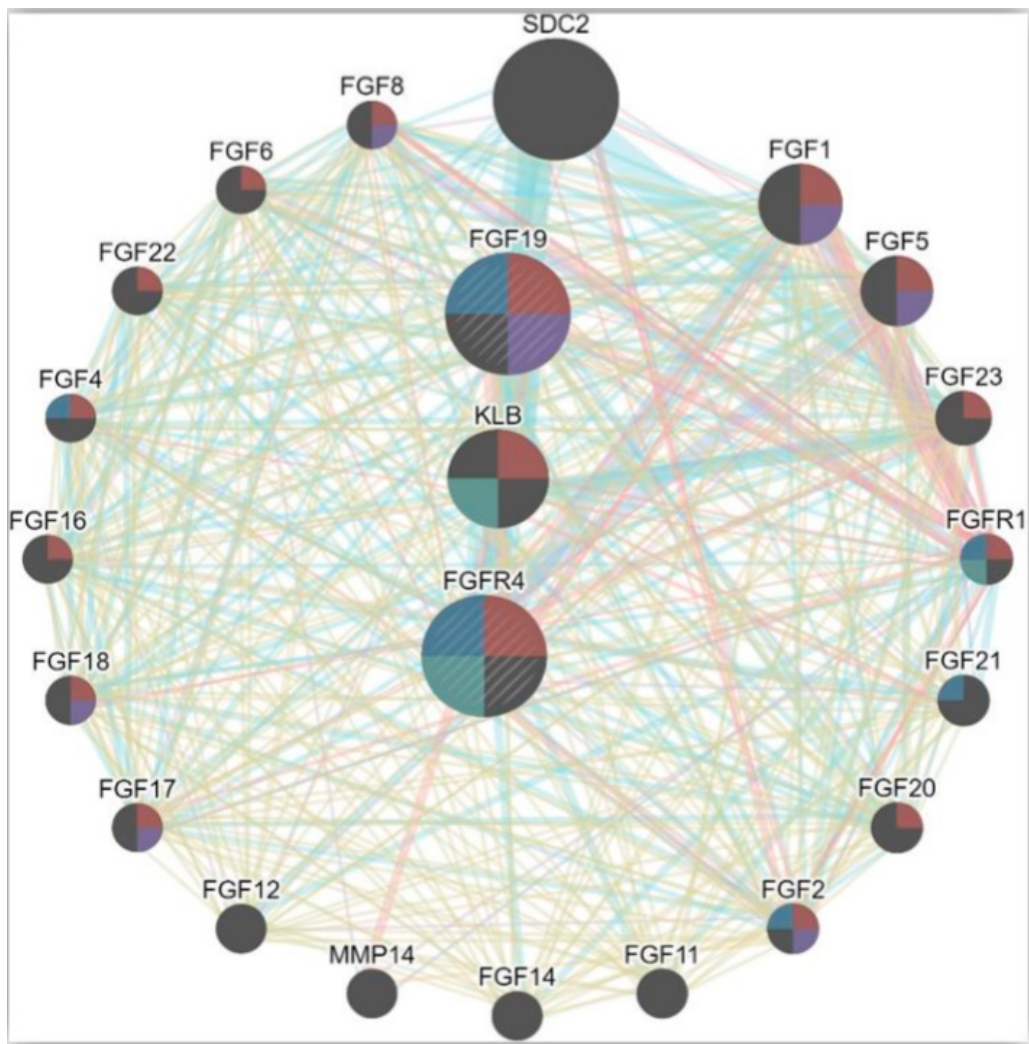
Figure 4. Interaction network of FGFR4 with different genes with high potency and functional similarity. The interaction network is based on various parameters including co-expression, genetic interactivity, shared protein domains, co-localization and physical interactions.